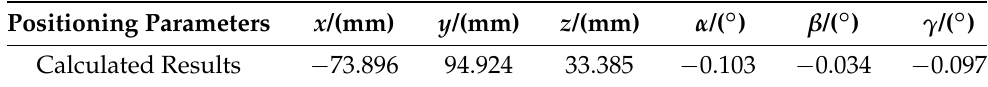
Figure 12. ( a – f ) Process of positioning parameters measurement of multi-axis LEMT . Table 3. Positioning parameters calculated